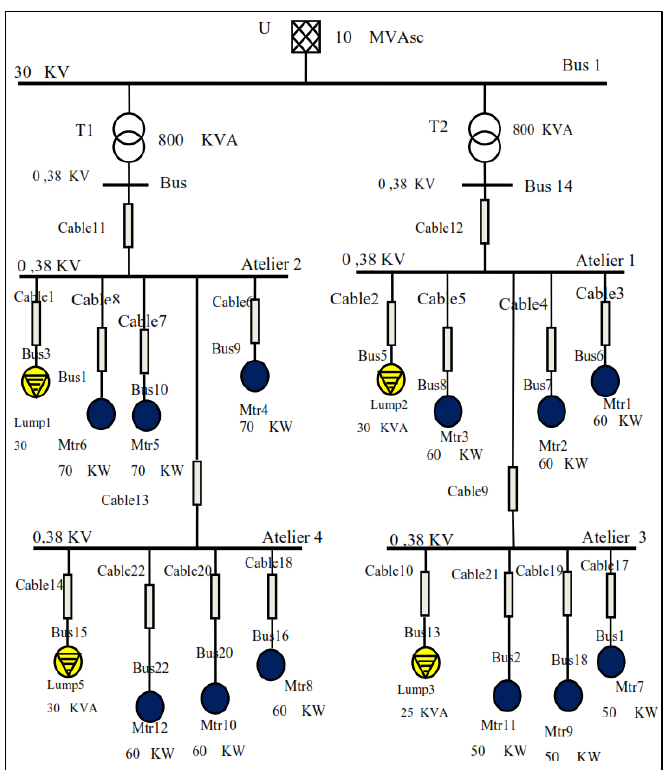
Figure 1: Structure of the proposed industrial electricity